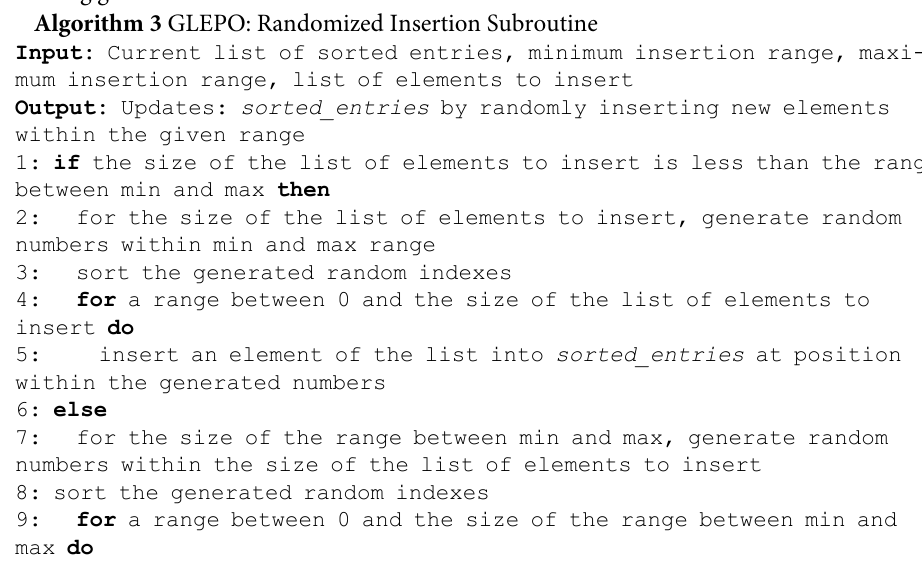
Algorithm 3 GLEPO: Randomized Insertion Subroutine